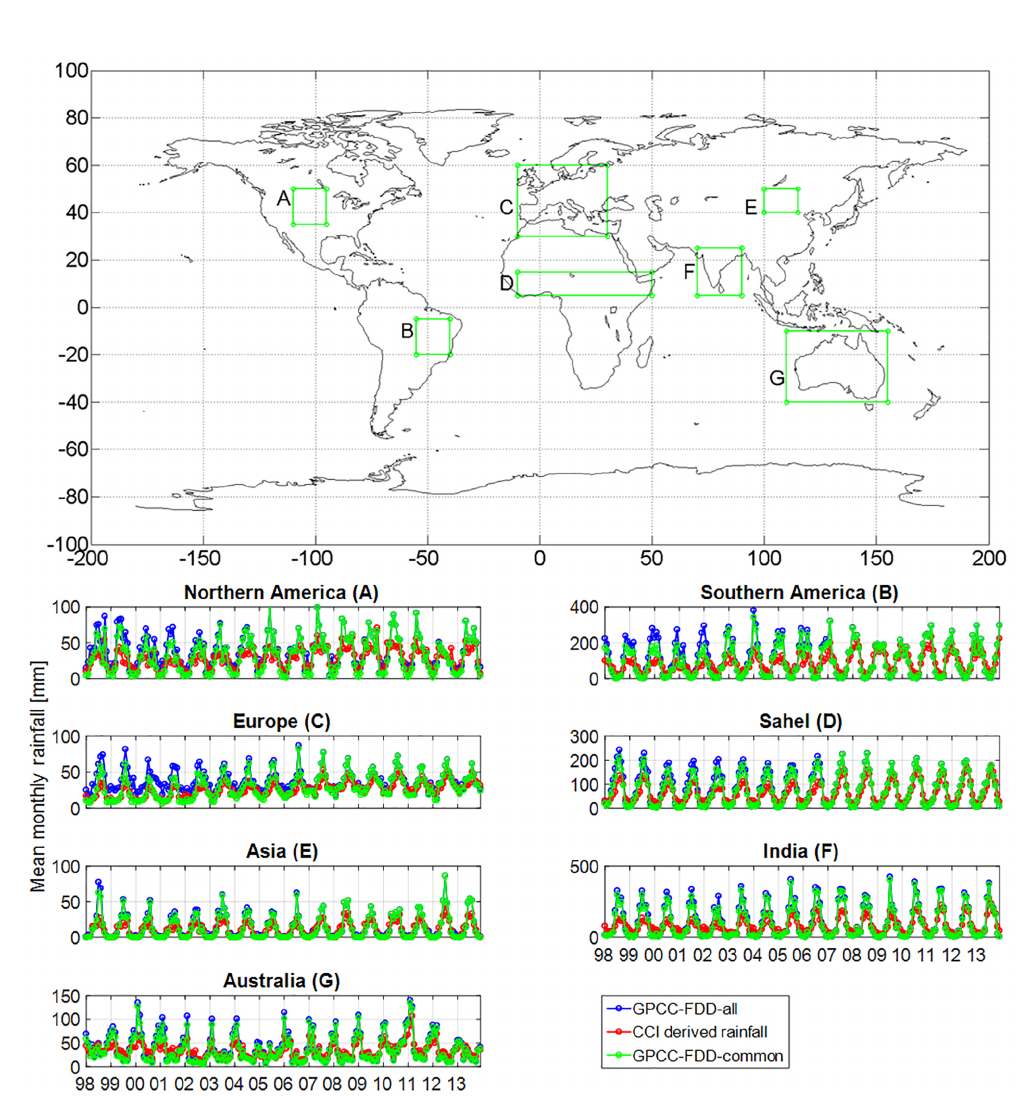
Figure 6. Mean monthly rainfall estimated by GPCC-FDD (blue line) and the new CCI-derived rainfall data set (red line) over the six analysis boxes throughout North America (A), South America (B), Europe (C), Sahel (D), Asia (E), India (F) and Australia (G) during the period 1998–2013. The blue lines draw the mean monthly rainfall estimated by GPCC-FDD when both a ground-based and a SM-derived rainfall estimate is